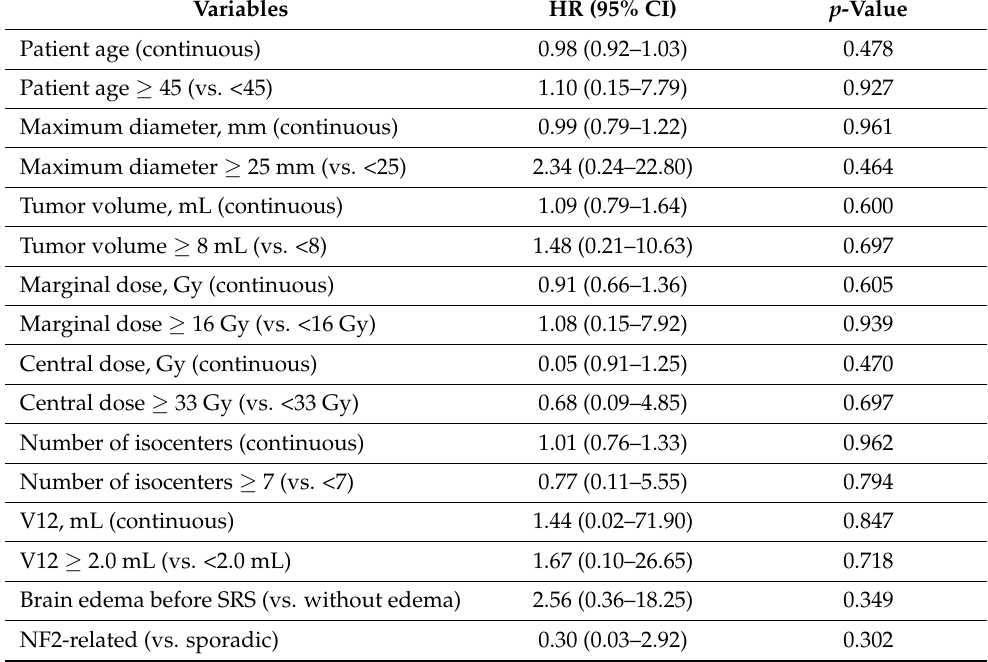
Figure 4. Kaplan–Meier curves for functional preservation rates ( A ) and cumulative post-stereo- tacitic radiosurgery T2 signal change rates ( B ). radiosurgery T2 signal change rates ( B ). Table 3. Bivariate Cox proportionate analysis on post-SRS signal change. Table 3. Bivariate Cox proportionate analysis on post-SRS signal